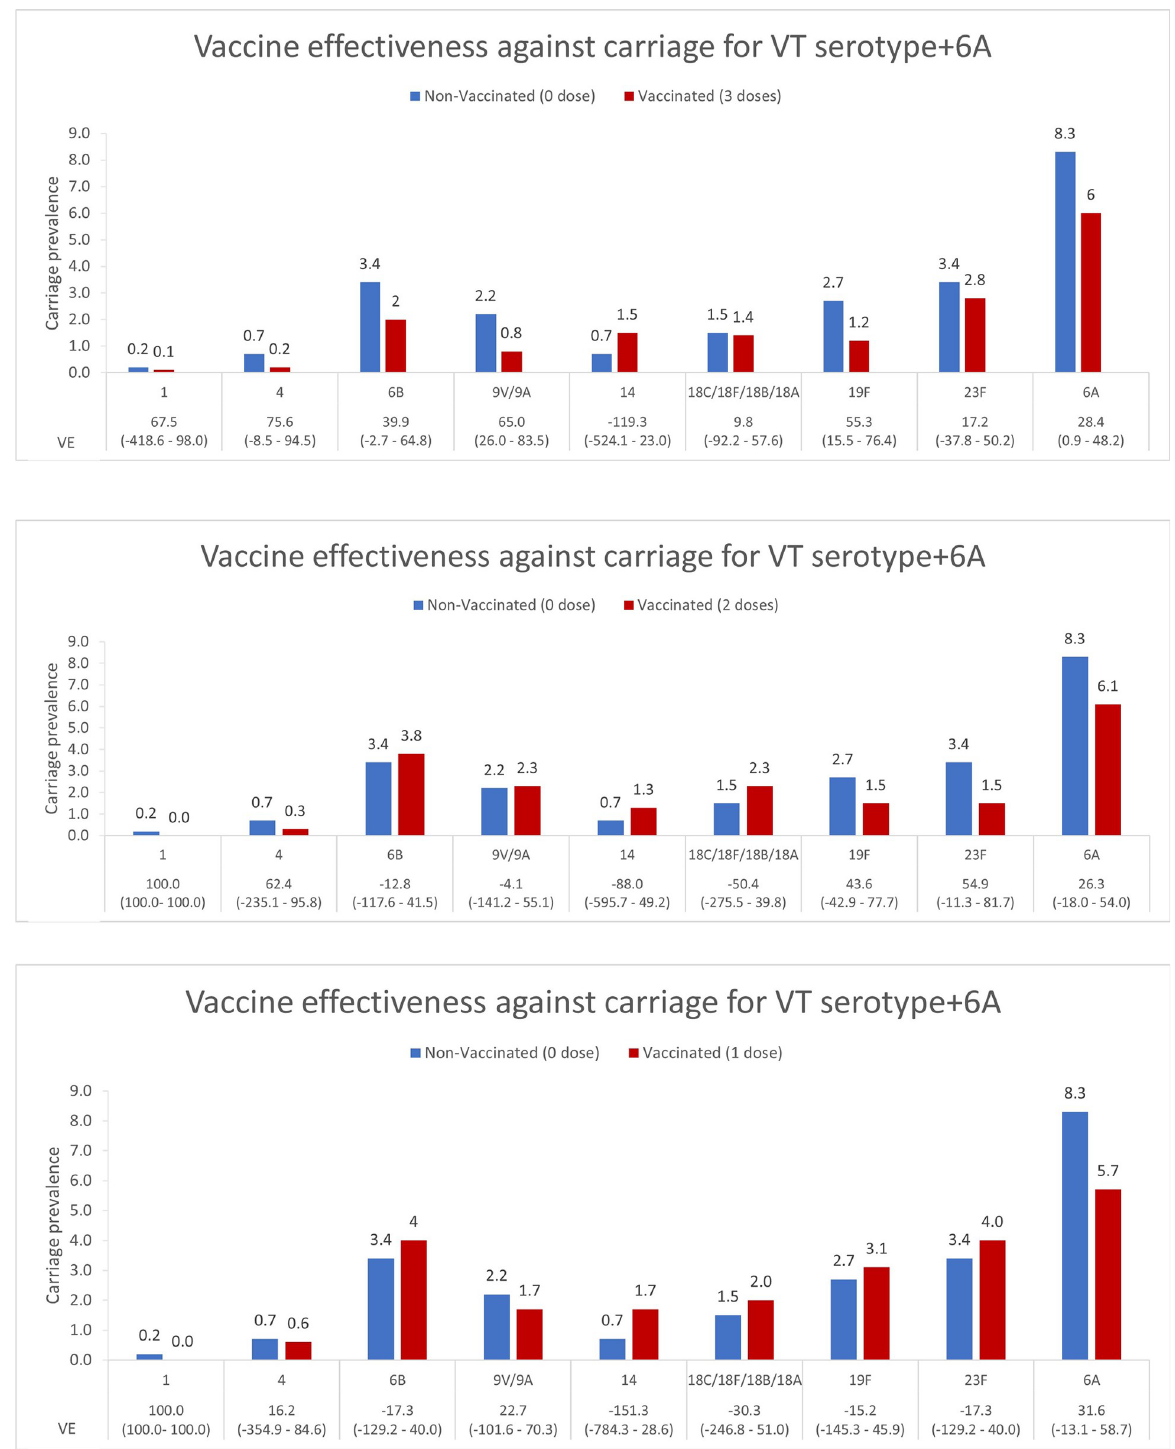
Fig 2. Vaccine effectiveness against specific serotypes, (a) 0 dose vs 3 doses, (b) 0 dose vs 2 doses and (c) 0 dose vs 1 dose.